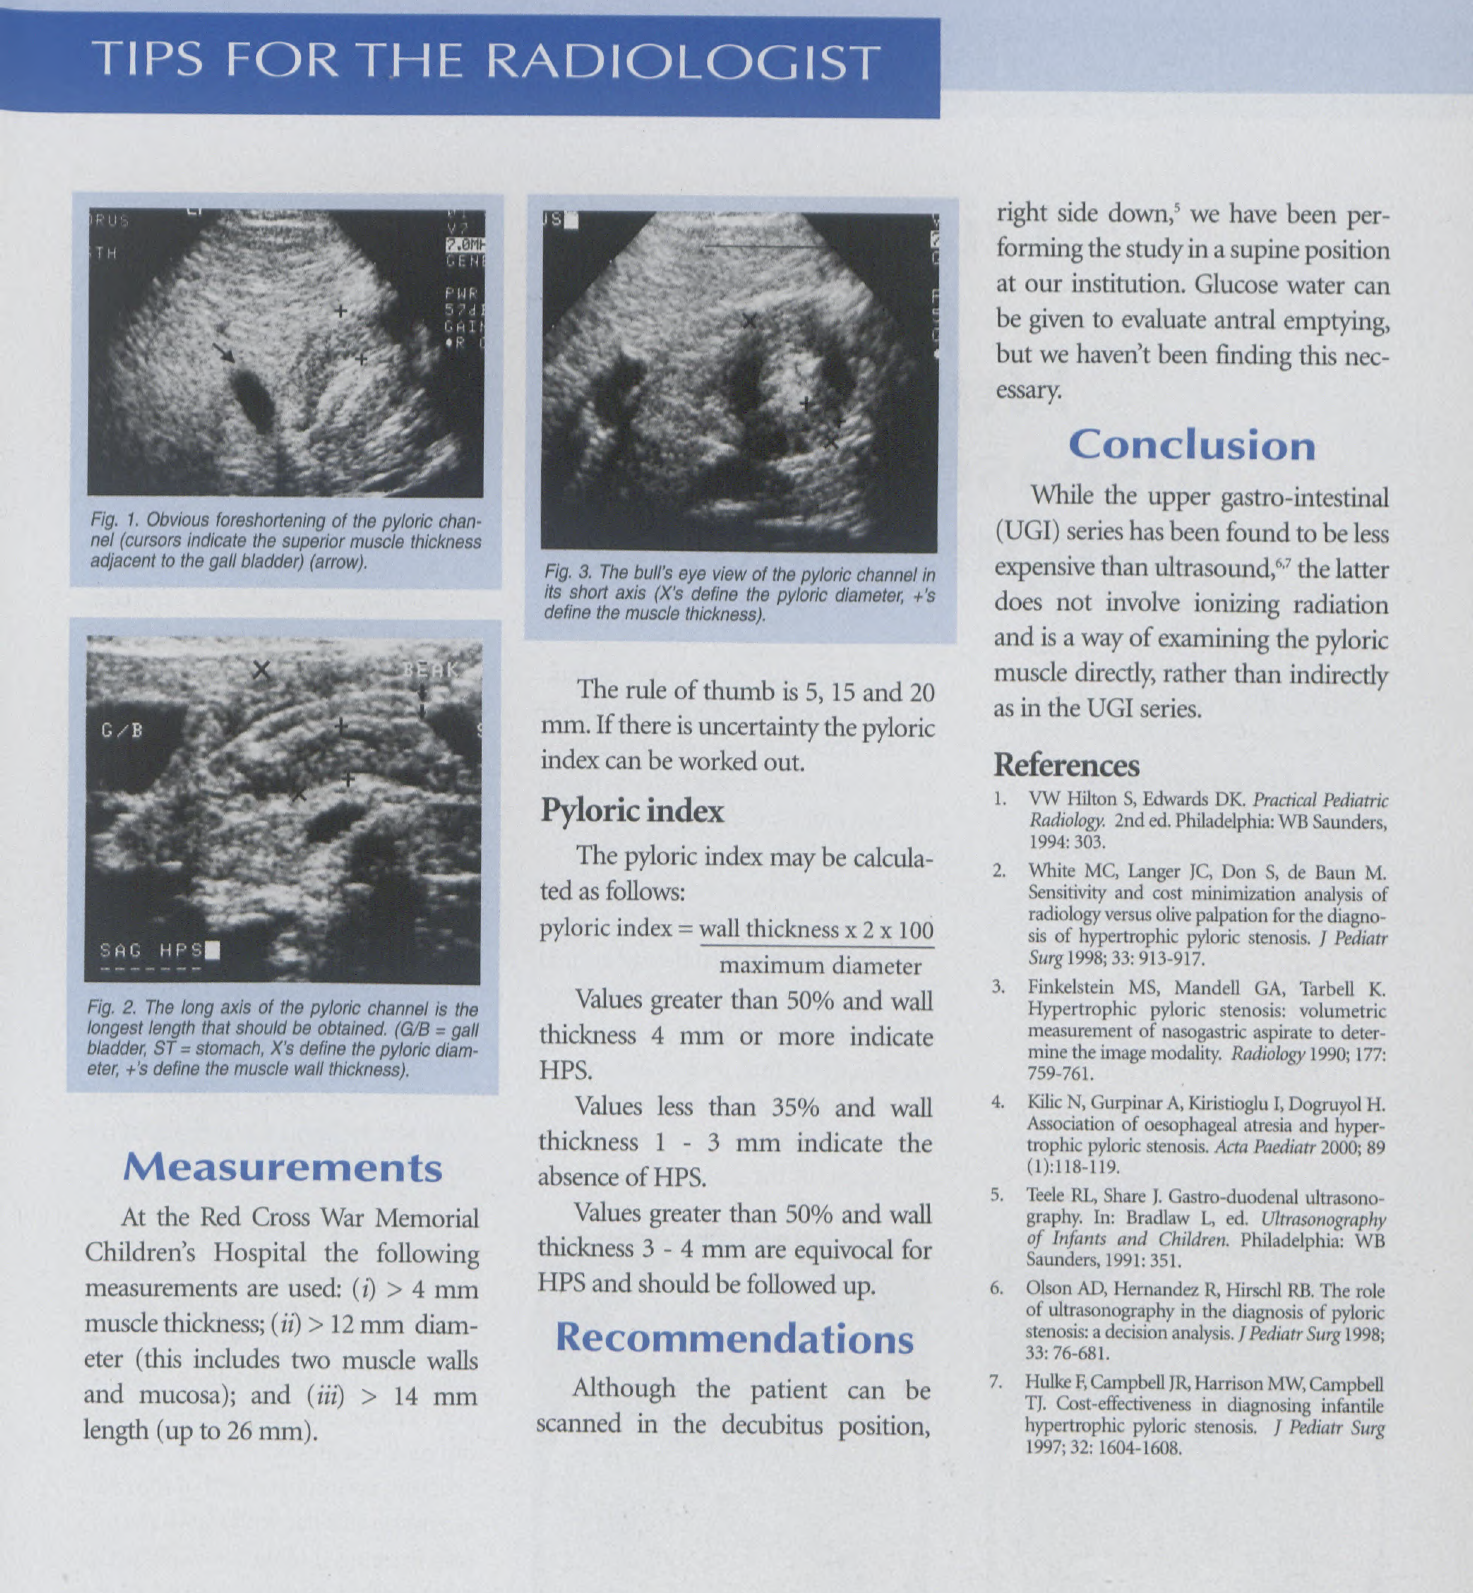
Fig. 1. Obvious foreshortening of the pyloric chan- nel (cursors indicate the superior muscle thickness adjacent to the gall bladder) (arrow).